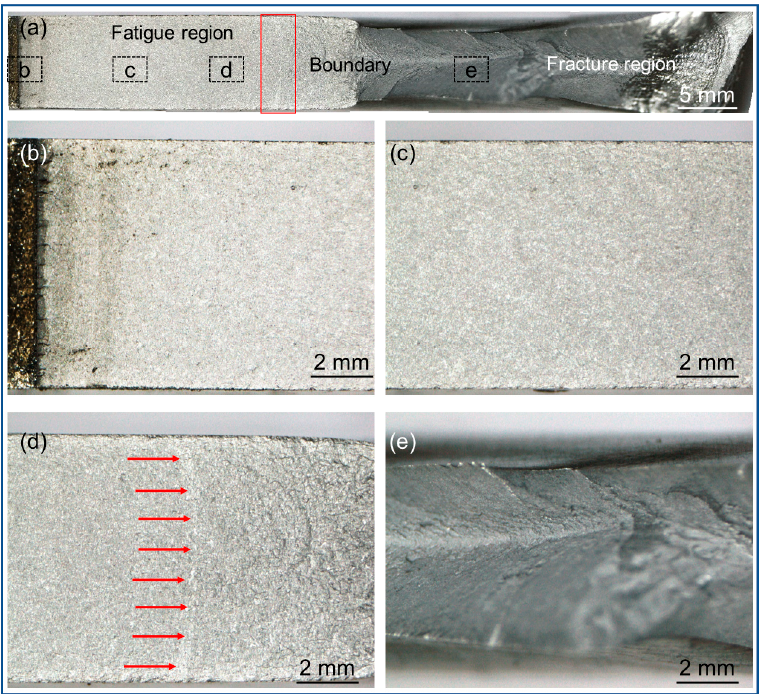
Figure 11. Fracture morphologies of samples for testing the fatigue crack propagation rate ( a ) is the macro fracture morphology; ( b ) is fatigue crack initiation zone; ( c ) is the fatigue crack stable growth zone; ( d ) is the fatigue crack instability propagation zone; ( e ) is the fault zone).